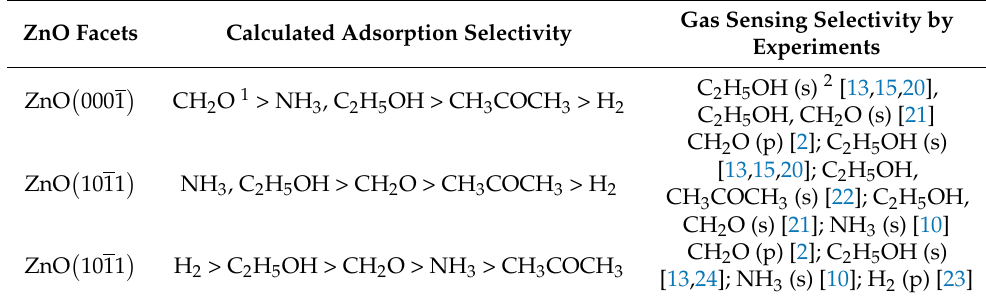
Table 2. Comparison between the calculated selectivity and the published experimental results.